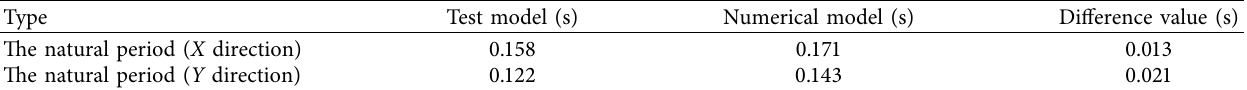
Table 7: The comparison of nature period of the test model and numerical